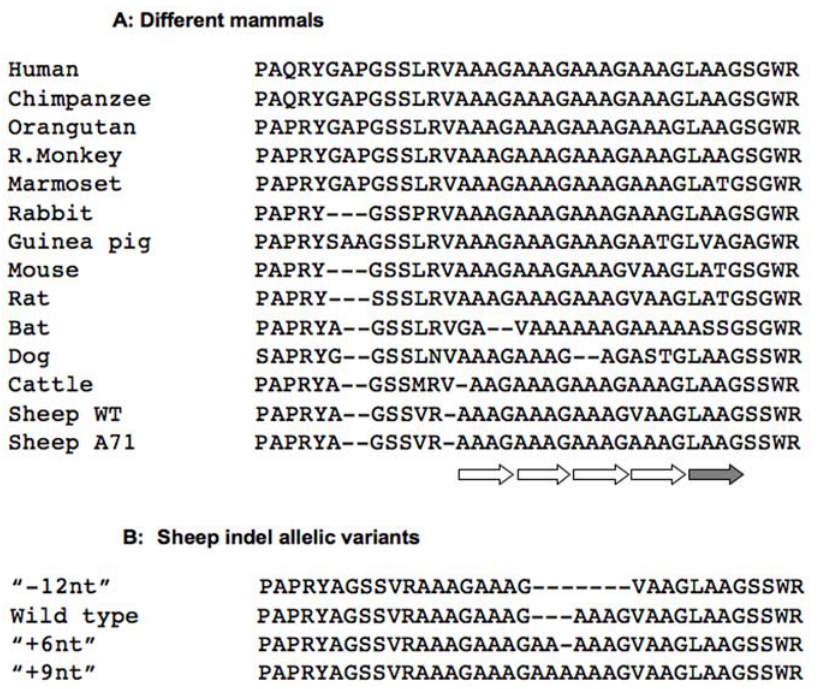
Figure 5. Alignment of Sho proteins. (A). Alignment of amino acid sequences (Clustal W) of the central regions of diverse Sho proteins. The hydrophobic domain area including amino acids 48 to 82 (according to the wild type sheep numbering) is presented. The four perfect (Ala) 3 Gly repeats are indicated underneath the sequences with open block arrows, while a fifth, degenerate repeat Leu(Ala) 2 Gly is indicated by a grey arrow. (B) Alignment of the sheep indel polymorphisms affecting the hydrophobic domain. For clarity, the wt sheep sequence is included in both types of alignment.